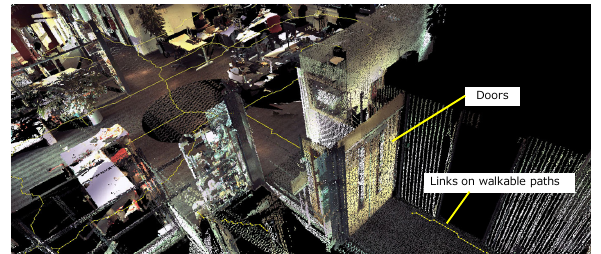
Figure 12. Unconnected links around a closed